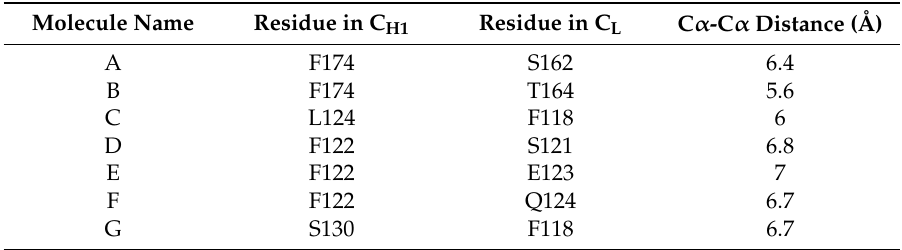
Table 1. The selected positions for introducing cysteine mutations in domains C H1 and C L . The C α -C α distance between the residues of each pair is indicated.